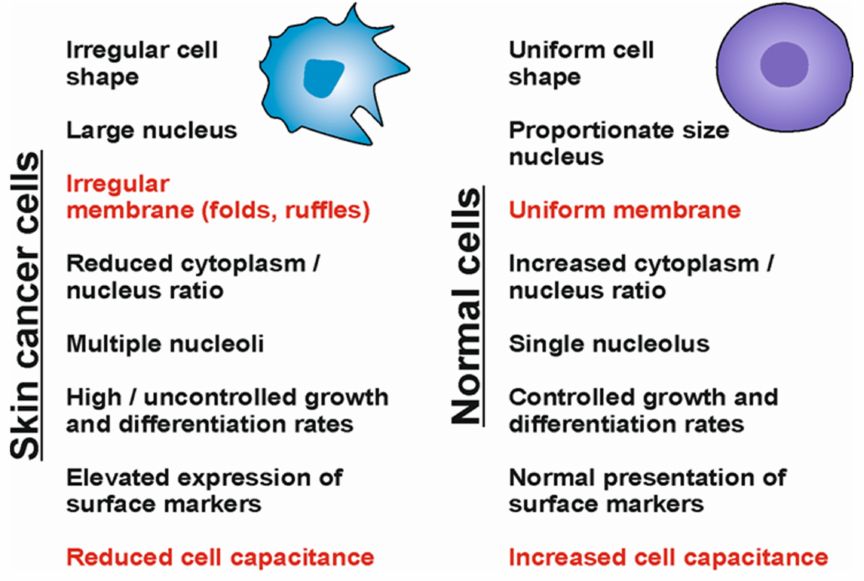
Figure 2. Skin cancer cells vs. normal cells—relevance for dielectrophoretic